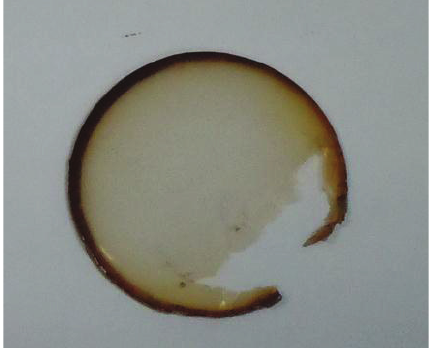
Figure 3: A photograph of the SPES film.